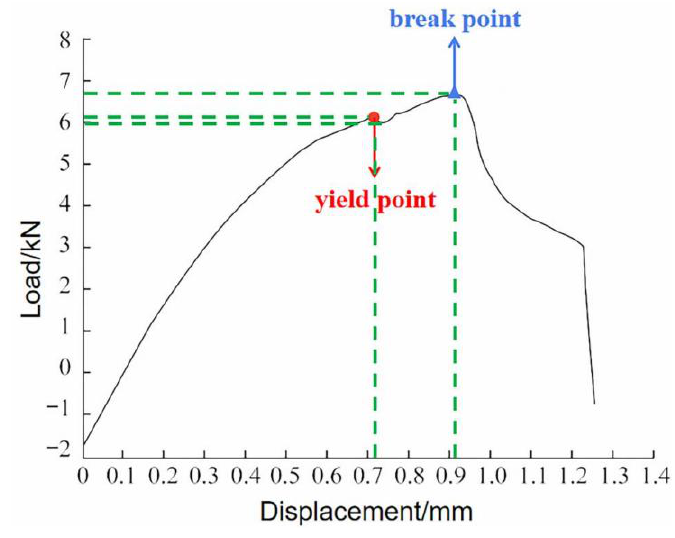
Figure 10. Tension curve of welded joint.